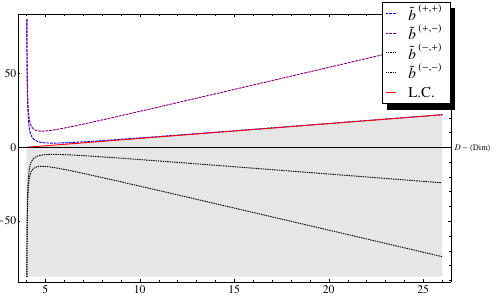
Figure 5 . Comparative plot of solutions ~ b (+ ; +) (dashed blue line), ~ b (+ ; (cid:0) ) (dashed purple line), ~ b ( (cid:0) ; (cid:6) ) (dotted black line) and the localization condition | L.C. (red line).